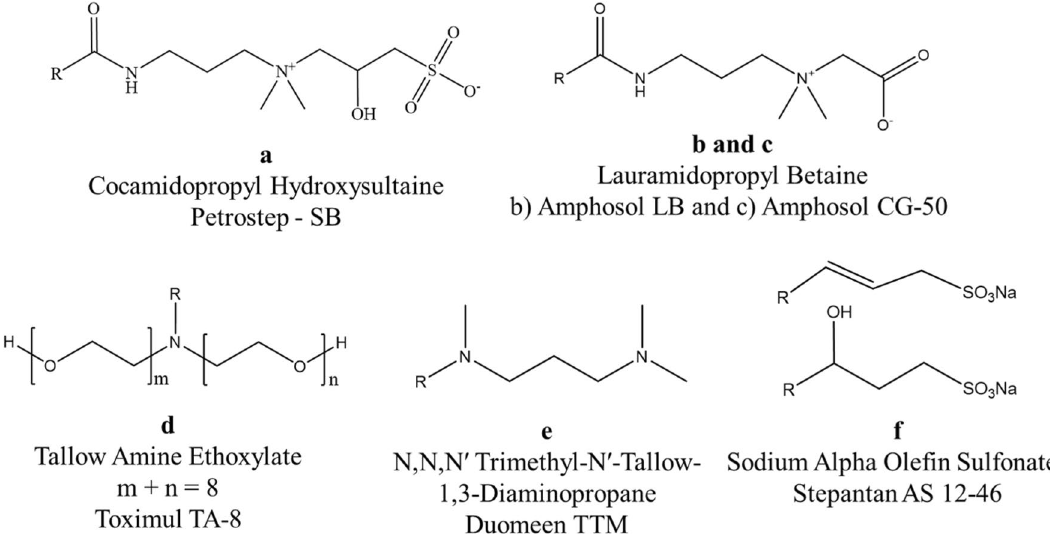
Figure 1. Chemical structures of the surfactants used in this study. ( a ) Cocamidopropyl hydroxysultaine used as active ingredient in Petrostep SB, ( b , c ) lauramidopropyl betaine with R = 11–13 in ( b ) Amphosol LB (from narrow cut methyl esters) and R = coco in ( c ) Amphosol CG-50 (derived from refined coconut oil), ( d ) tallow amine ethoxylate with m + n = 8 and R = ~ 19 in Toximul TA-8, ( e ) N,N,N ′ trimethyl-N ′ -tallow-1,3-